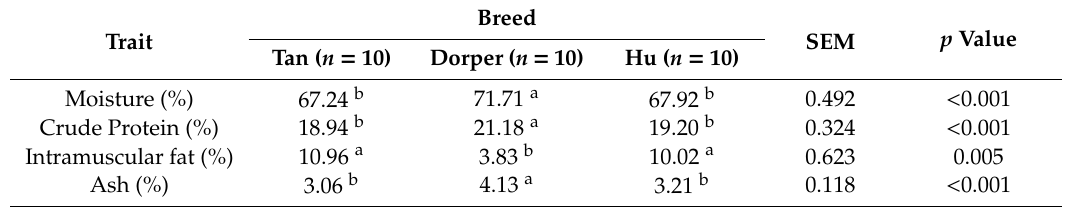
Table 2. Chemical analysis of Longissimus thoracis et lumborum (LTL) for Tan, Dorper and Hu.